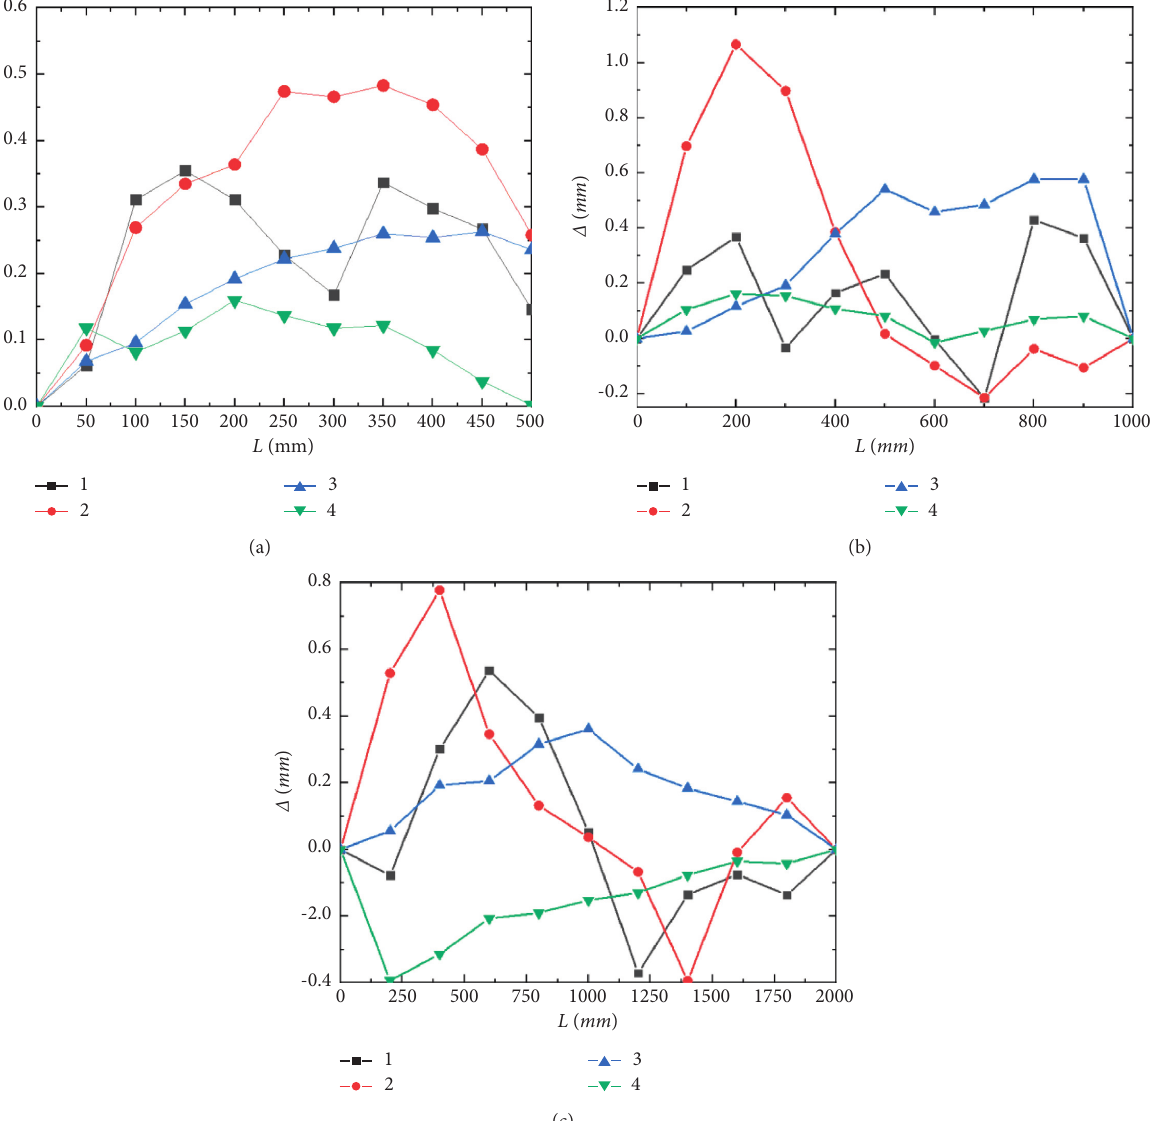
Figure 6: Initial geometric imperfections of specimens. (a)Specimen C80-05-1H3-1. (b)Specimen C80-10-1H3-1. (c)Specimen C80-20-